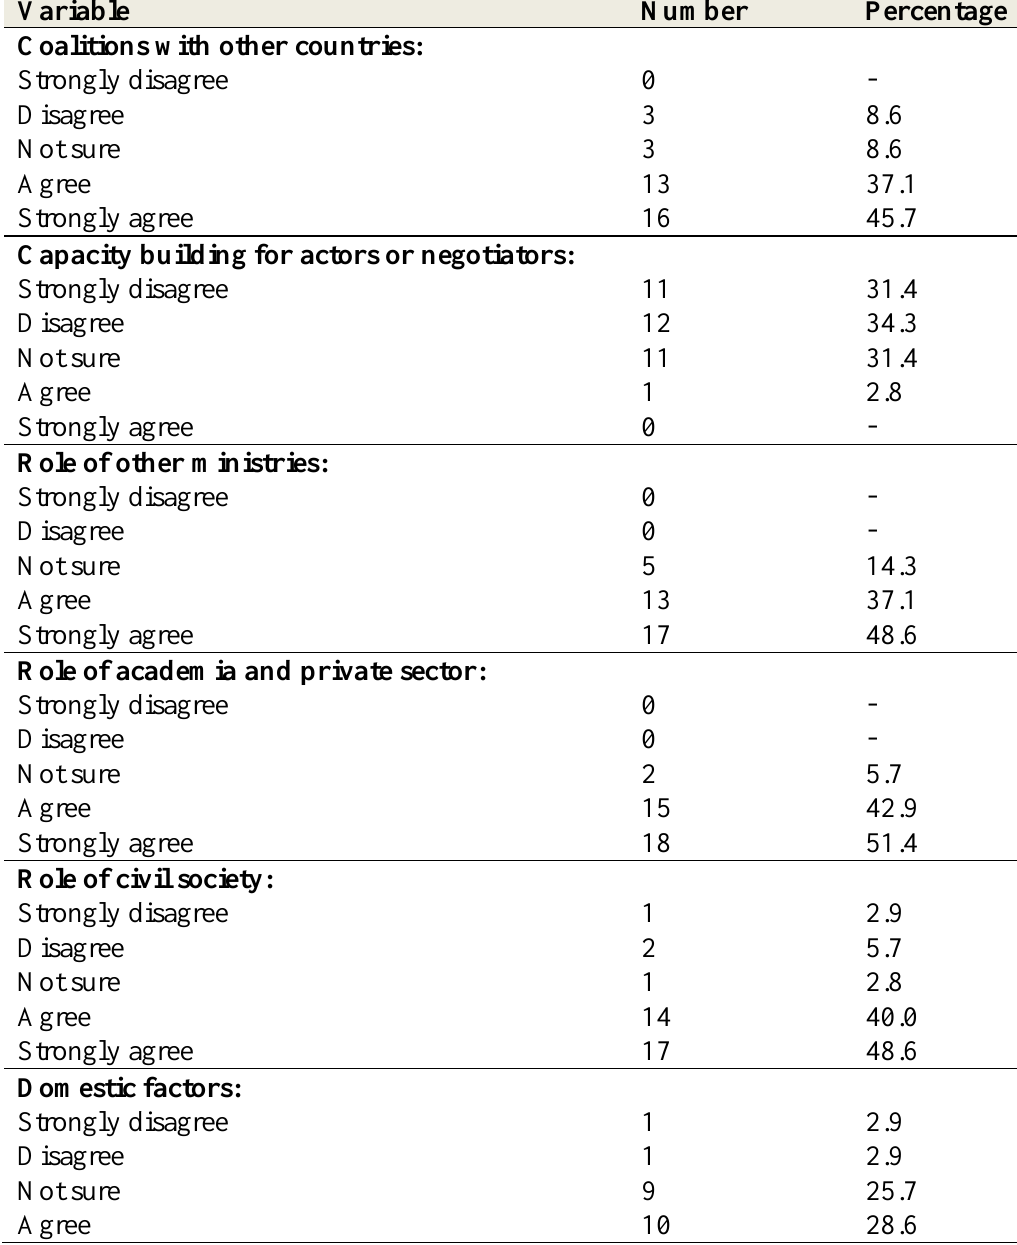
Table 3. Strategies, approaches and domestic factors used to advance global